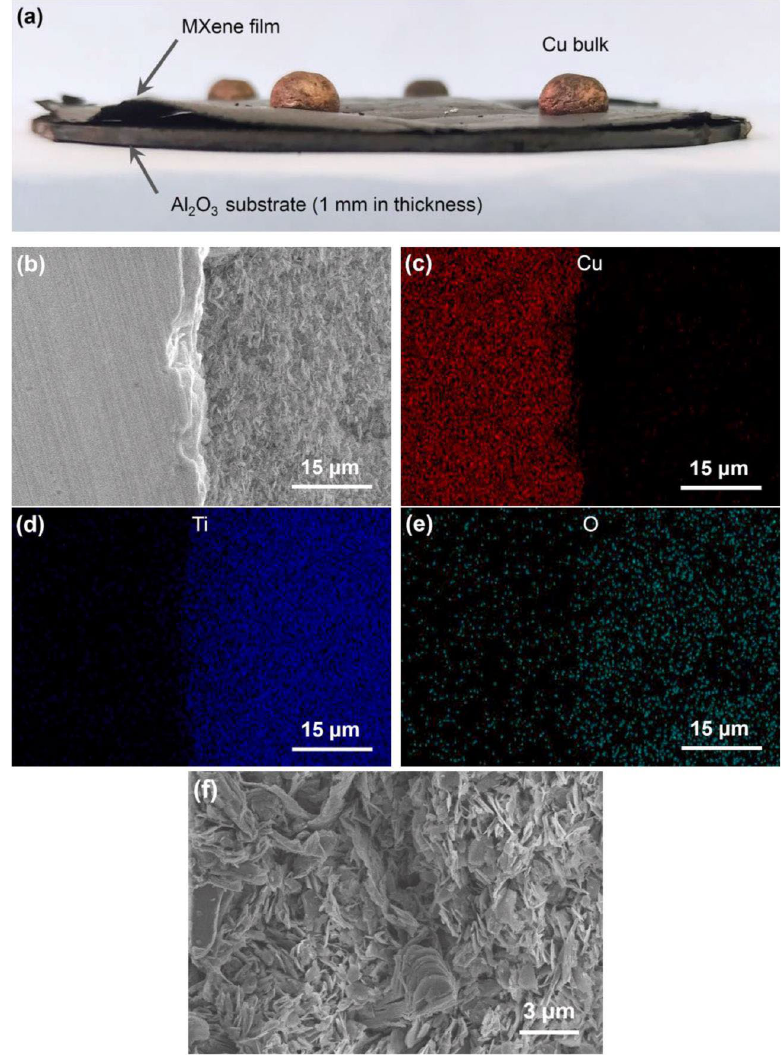
Figure 38. ( a ) The optical photograph of wettability test between Cu bulks and MXene film, and ( b – e ) the secondary electron SEM image and corresponding elemental mapping near the interface between Cu bulk and MXene film: ( b ) the SEM image, ( c ) Cu element, ( d ) Ti element, ( e ) O element, and ( f ) enlarged images of MXene film area